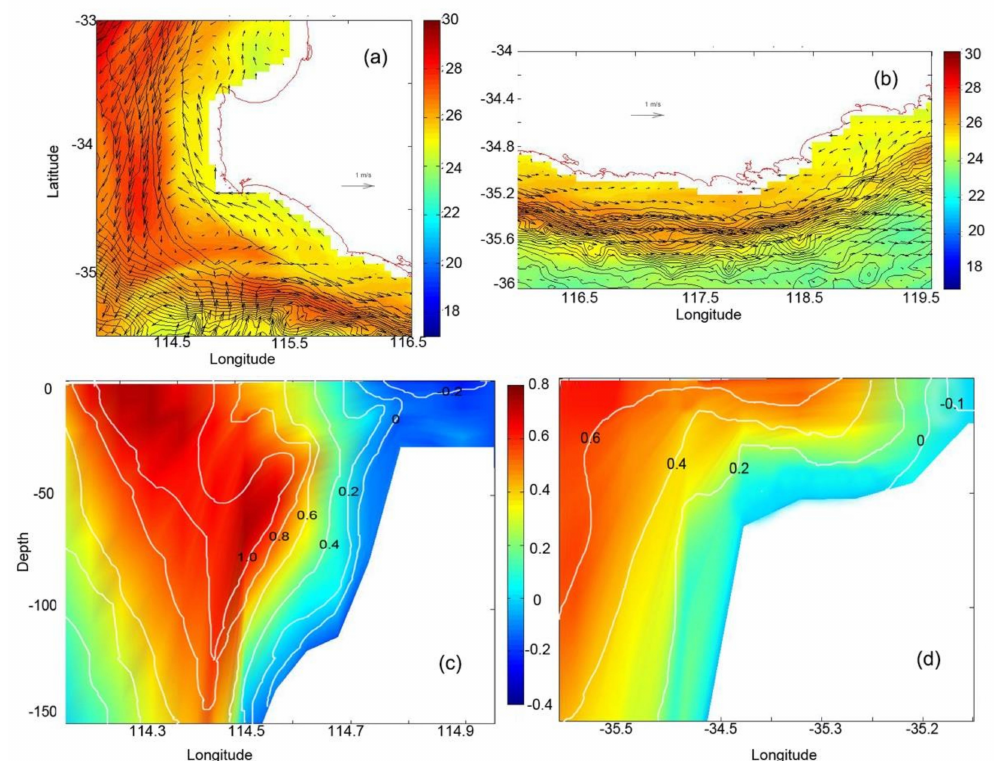
Figure 10. ( a ) Sea surface temperature ( ◦ C) and Capes current velocity for the Capes region in autumn. ( b ) Sea surface temperature ( ◦ C) and Cresswell current velocity for the Albany region in autumn. ( c ) Transect R (Capes region) cross-section of the Capes current north-south velocity (m / s) in autumn. ( d ) Transect K (Albany) cross-section of the Cresswell current north-south velocity (m / s) in autumn. The color bars indicate the velocity in m /